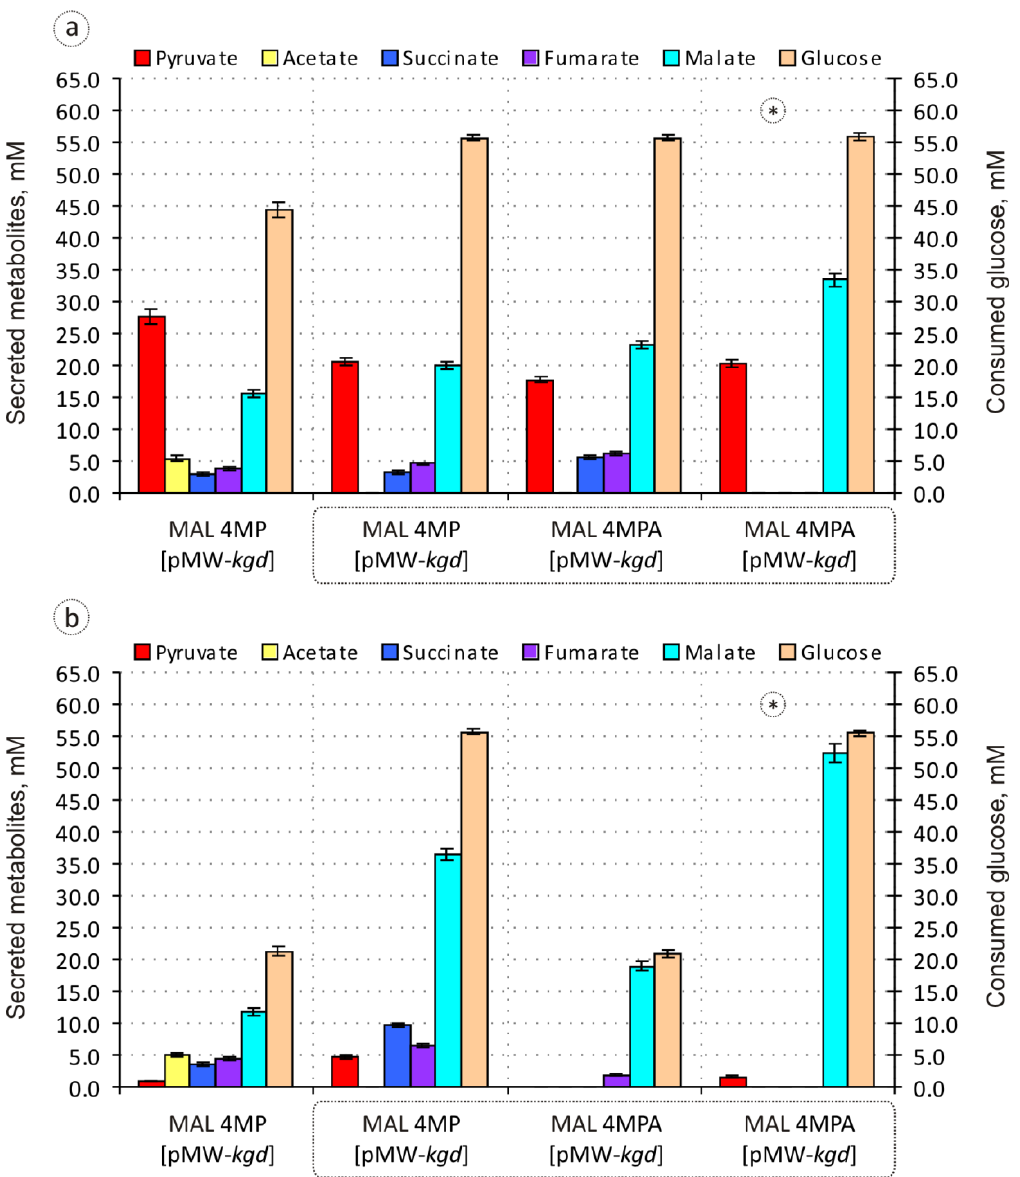
Figure 3. Metabolite production and substrate consumption by the strains MAL 4MP [pMW- kgd ] and MAL 4MPA [pMW- kgd ] strains during 8 h and 19 h (marked with dotted square) of aerobic glucose utilisation in the absence ( a ) or presence ( b ) of IPTG. The parameters for the strain MAL 4MPA [pMW- kgd ] functioning in “biocatalyst” mode are marked with asterisks.